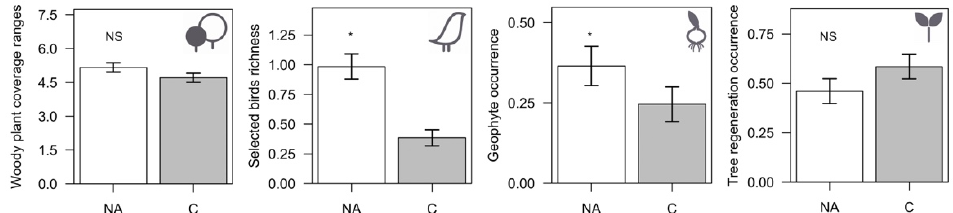
Figure 4. Differences in the frequency of the selected ecological indicators between remnant natural areas on adjacent slopes (NA), and vegetation strip corridors (C) within the vineyards. From left to right: “Woody plant coverage”, “Bird species”, “Geophytes”, and “Tree regeneration”. Significance: NS = p > 0.05, * = p ≤ 0.05.